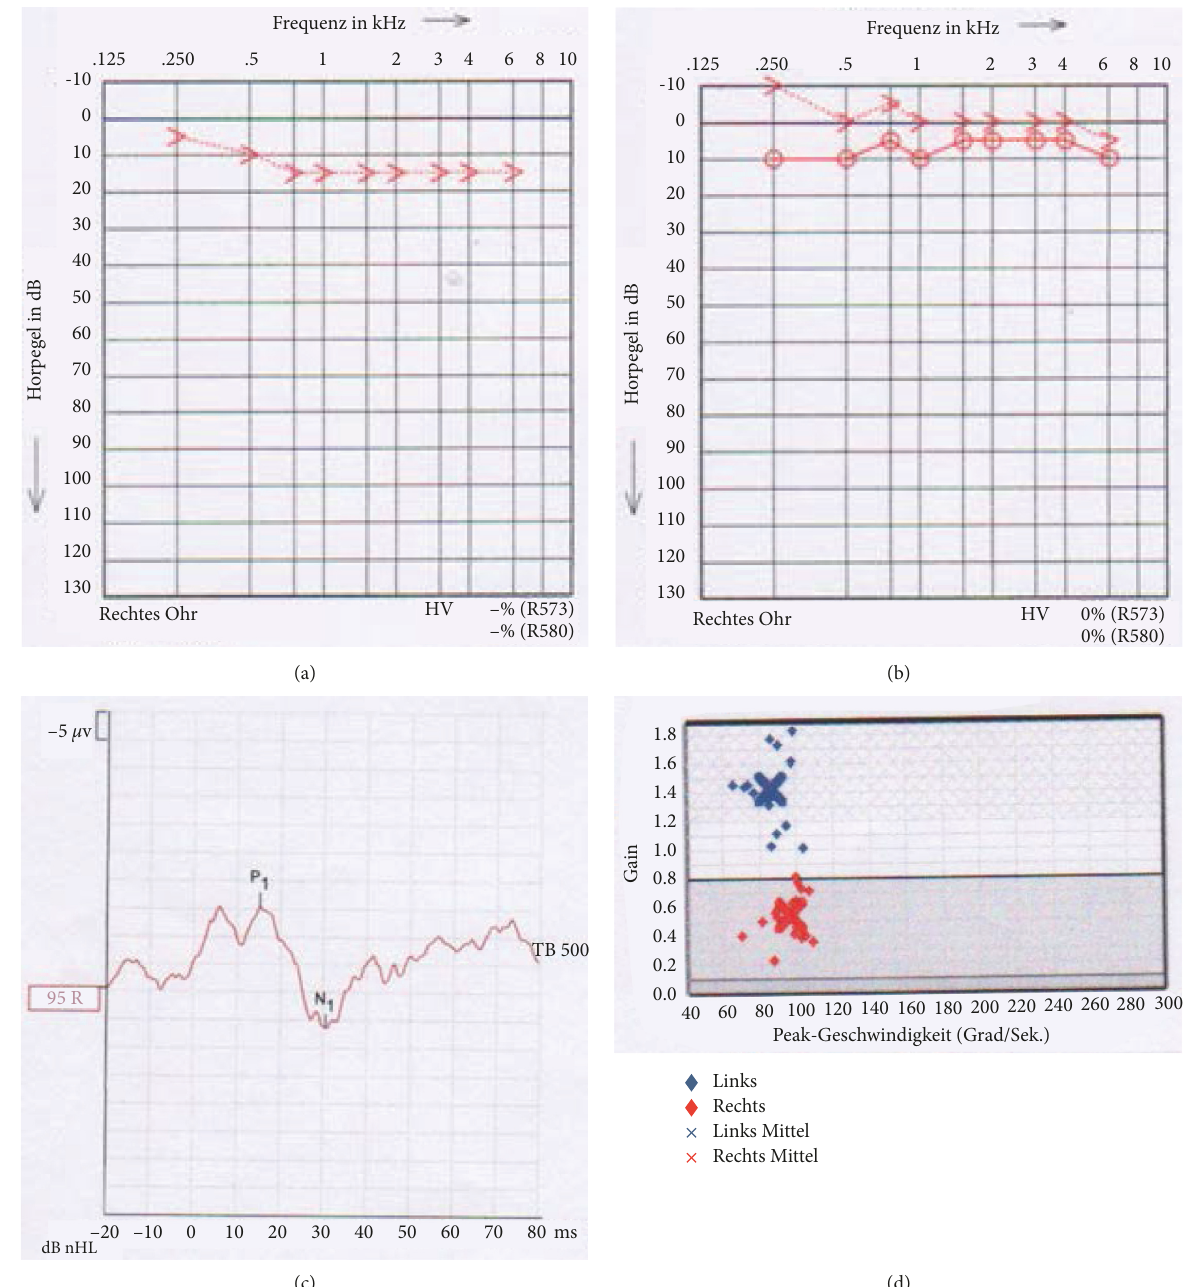
Figure 2: (a) PTA on the 1st postoperative day after tympanoscopy with round window coverage on the right. Increase of the BC threshold of 5–15dB pantonal. (b) PTA 3 weeks after tympanoscopy with round window coverage on the right. Complete regression of the BC threshold on the right. (c) Presence of a response when examining the cVEMP. (d) vHITof the right lateral semicircular canal. Increase of gain up to